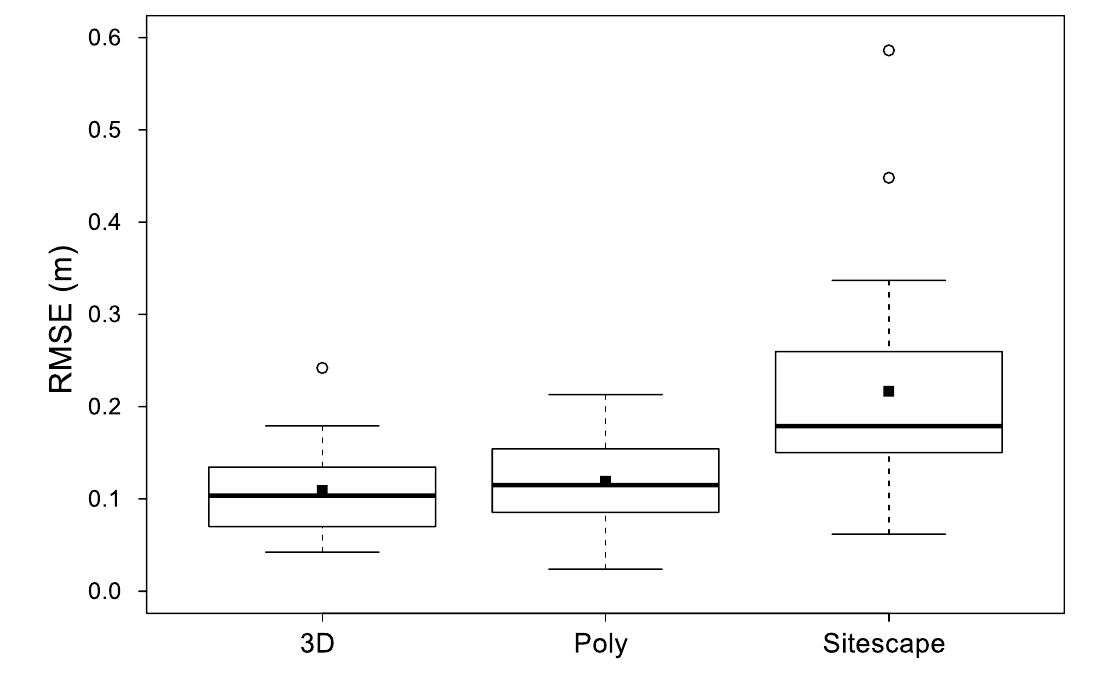
Figure 13. Distribution of tree location RMSE for iPad.